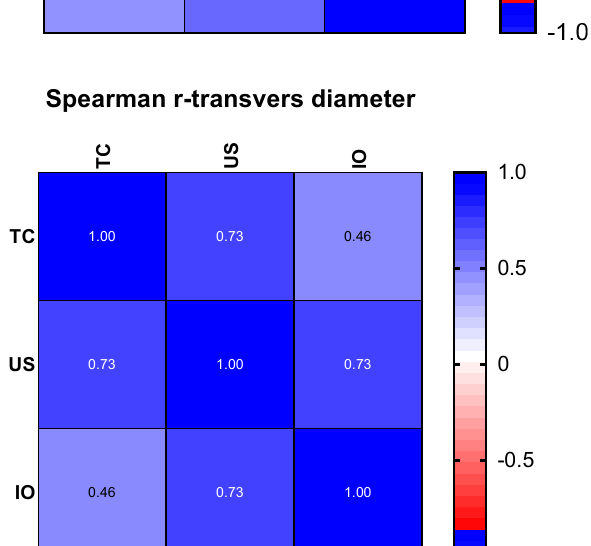
Figure 5. Bland-Altman analysis comparing anteroposterior diameter measured using ultrasound versus intraoperative measurement (US = ultrasound, IO = intraoperatively). 50